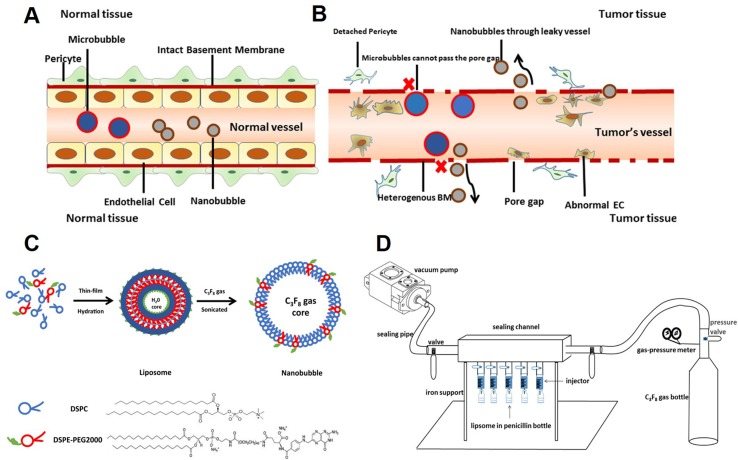
Schematic illustration of this study. (A) Neither microbubbles nor nanobubbles can pass through the endothelial gap in normal tissues. (B) Microbubbles cannot pass the endothelial gap but nanobubbles can in tumor tissues. (C) The procedure for fabrication of nanobubbles. (D) The homemade setup for exchanging octafluoropropane (C3F8) gas.